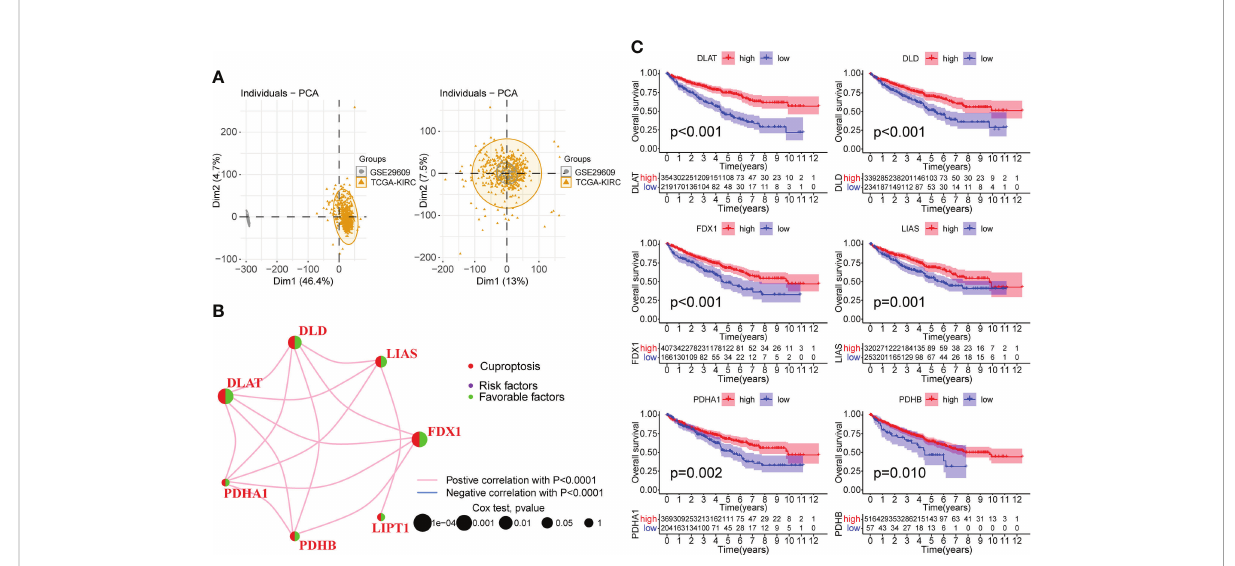
FIGURE 2 Correlation analysis and survival analysis of CPGs in KIRC. (A) Fusion of TCGA-KIRC and GSE29609 cohort data and removal of batch effects. The left plot shows PCA before removing batch effects, and the right plot shows PCA post removing batch effects. (B) Correlation network of seven CPGs. The line represents a correlation between genes, the sphere represents the COX test of each gene. (C) Kaplan-Meier survival analysis of CPGs in KIRC (OS, Log-rank test, p < 0.05). CPG, cuproptosis-promoting